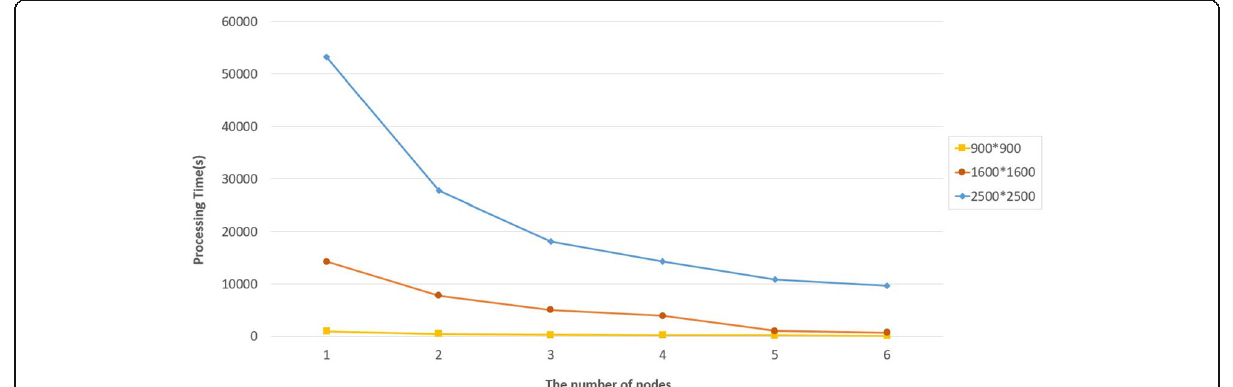
Fig. 10 Performance comparison of CPU resource with respect to the number of nodes on RIDE